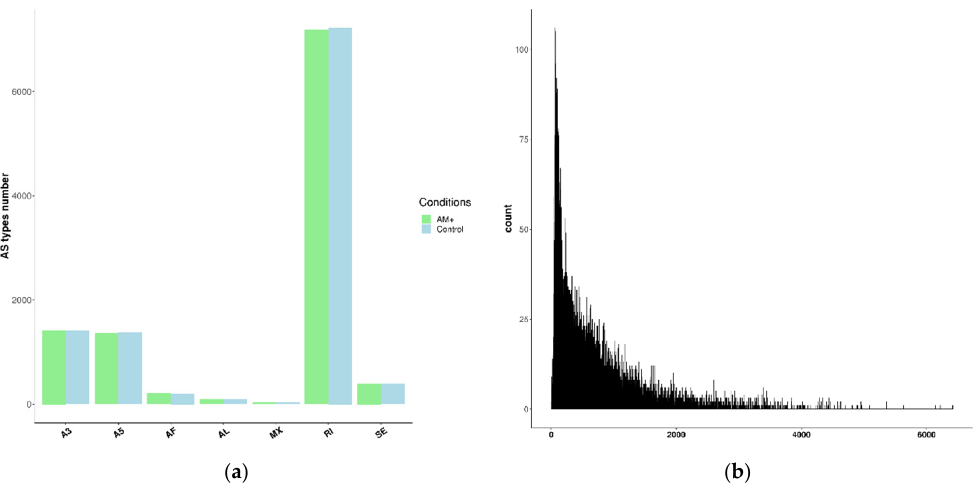
Figure 2. ( a ) Distribution of AS types in mycorrhizal and control roots of P. sativum (A3—alternative 3 ′ splice sites; A5—alternative 3 ′ splice sites; AF—Alternative First Exon; AL—Alternative Last Exon; MX—Mutually Exclusive Exons; RI—Retained Intron; SE—Skipping Exon); ( b ) Distribution of lengths of introns based on RNAseq data. Table 2. Usage frequency of different splice-sites based on RNAseq reads mapping using STAR.